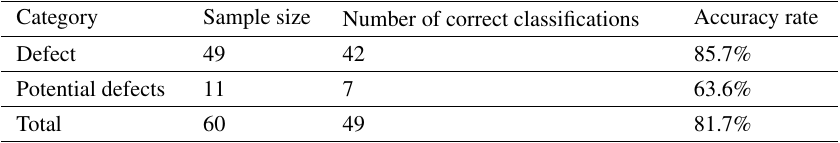
Table 5 Classification accuracy of decision